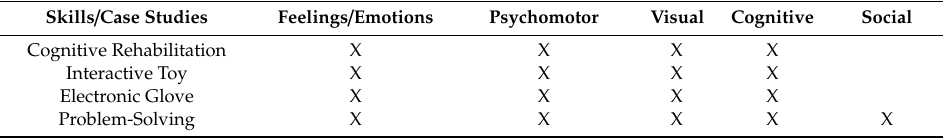
Table 3. Comparison to each case study in the skills development for children with hearing